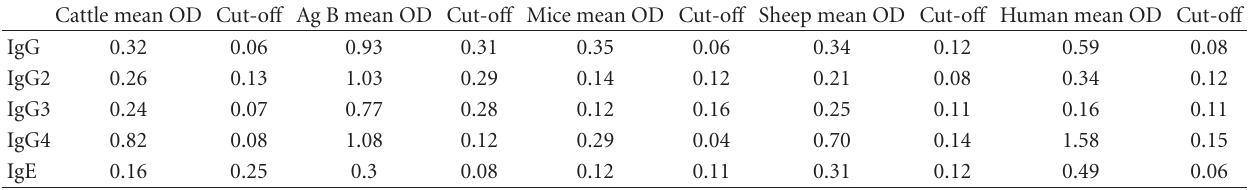
The mean di ff erence is significant at the 0.05 level. Table 10: The mean OD values IgG class, IgG subclass, and IgE of 30 human sample sera to crude HCF antigens of cattle, Ag B, mice, sheep, and human.